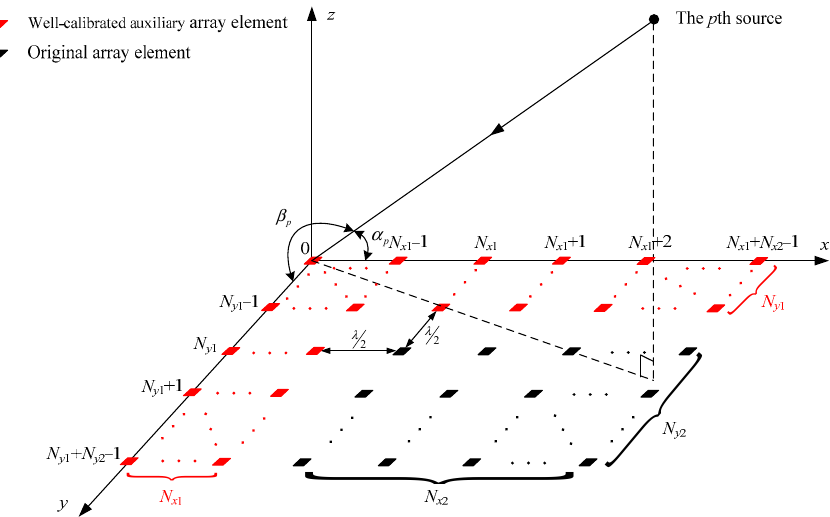
Figure 1. Geometry of the original and extended URAs for 2D DOA estimation. Assume that there are P noncoherent far-field sources located at the same range and the 2D DOA of the p -th source with respect to the x -axis and the y -axis are